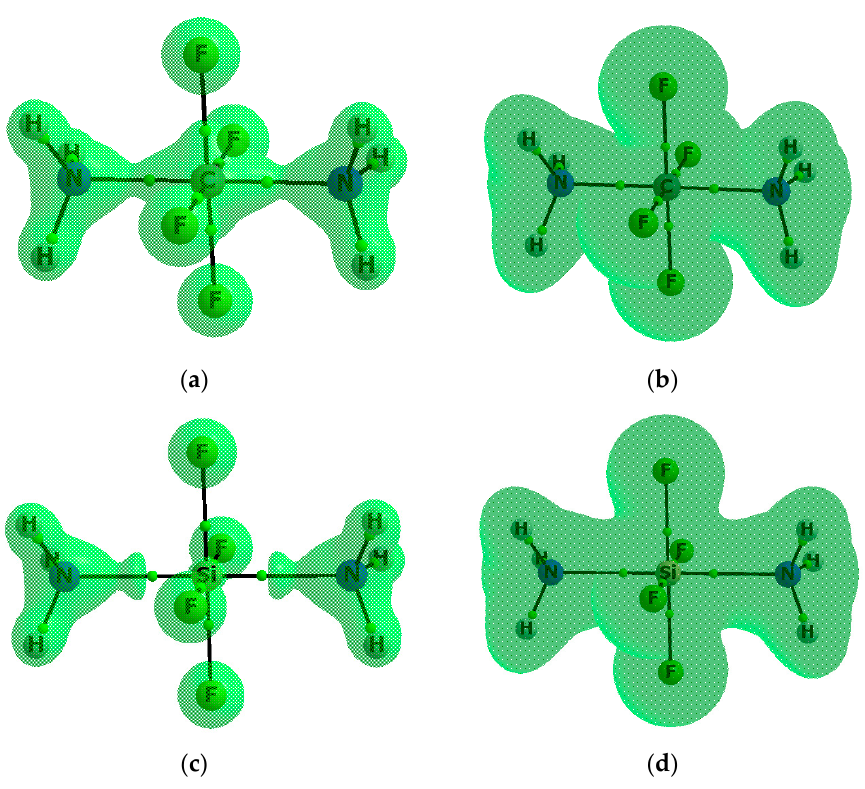
Figure 4. The molecular graph of the: CF 4 …(NH 3 ) 2 complex ( a , b ); and the SiF 4 …(NH 3 ) 2 complex ( c , d ). Solid lines correspond to bond paths, big circles to attractors and small green circles to BCPs; the reactive surfaces based on the Laplacian of electron density ( ∇ 2 ρ (r) = 0 isosurfaces ( a , c )) and based on the total electron energy density (H(r) = 0 isosurfeces ( b , d )).